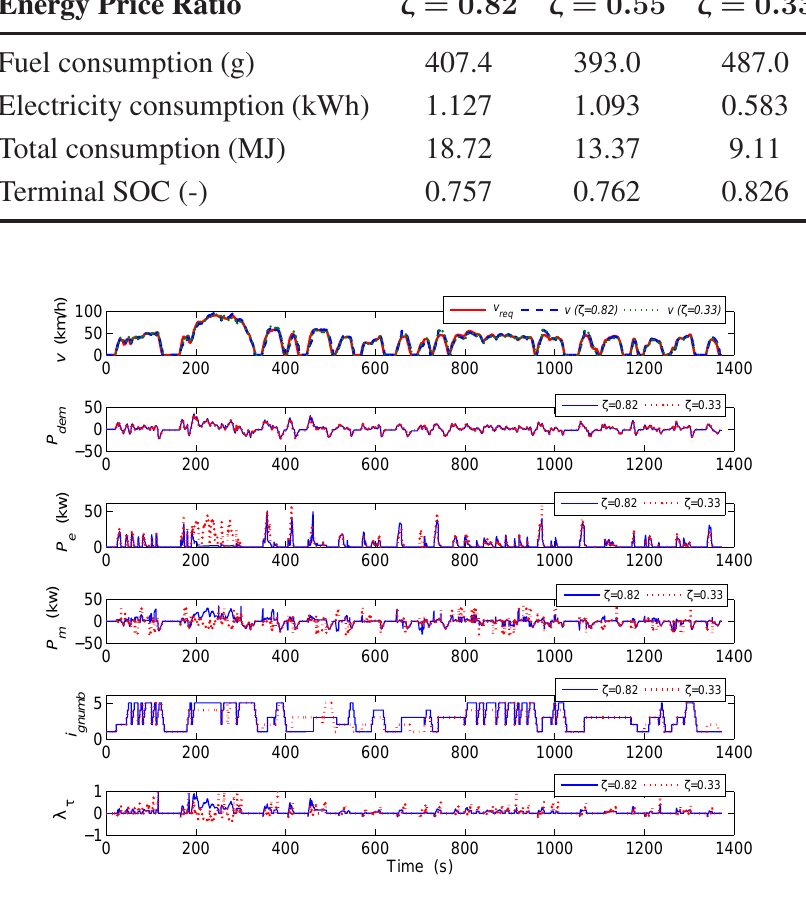
Figure 13. Vehicle speed, power demand, engine power, motor power, gear number and torque split ratio: ζ = 0 . 82 vs. ζ = 0 . 33